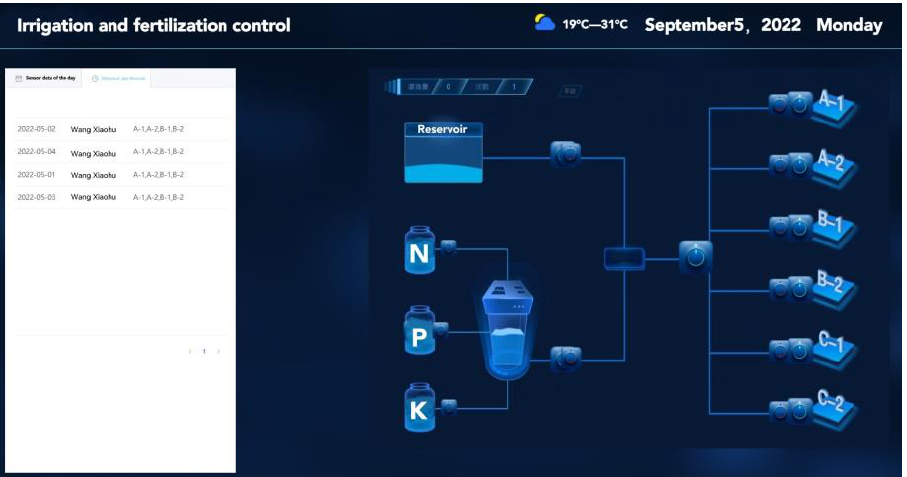
Figure 4. This is a figure. Schemes follow the same formatting.